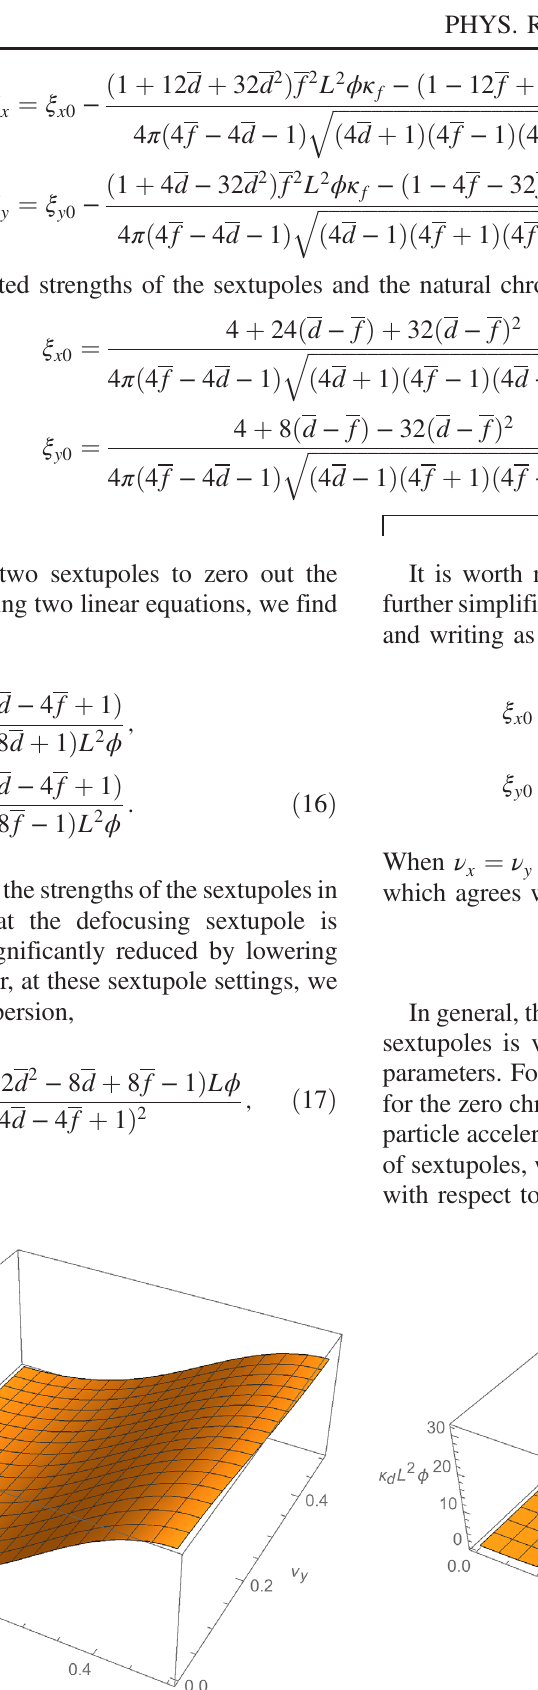
FIG. 2. The settings of focusing (left) and defocusing (right) sextupoles as a function of the betatron